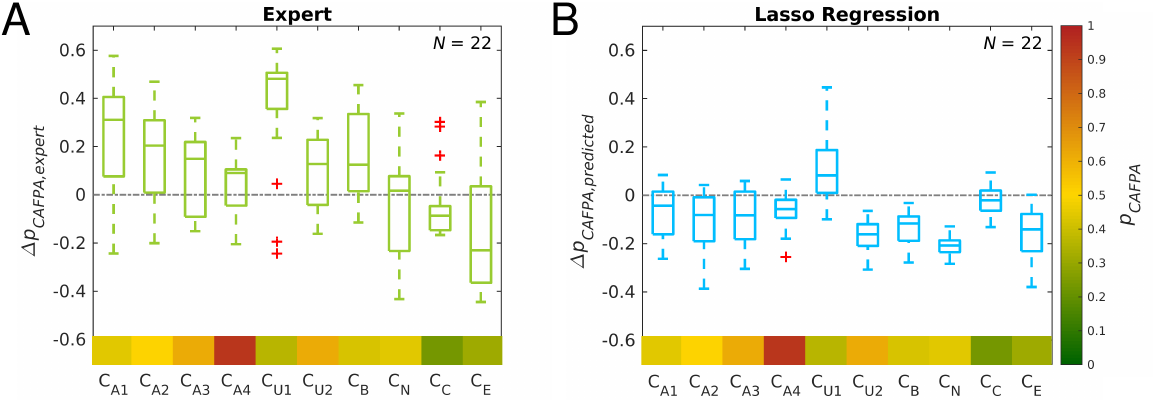
Figure 9. Differences ∆ p CAFPA between CAFPAs employed for classification and classification thresholds for all patients classified as CI by predicted CAFPAs (lasso regression) and classified as HA by expert-estimated CAFPAs in tree set III using rel-model weights ( N = 22 as depicted in Figure 8, top-right panel). Median and interquartile range are depicted. Positive values indicate classification as CI and negative values indicate classification as HA. Classification thresholds (for comparison set V, from Figure 3C) are displayed in the bottom row in the typical CAFPA color-coding. ( A ) Classification based on expert-estimated CAFPAs. ( B ) Classification based on predicted CAFPAs (lasso regression).